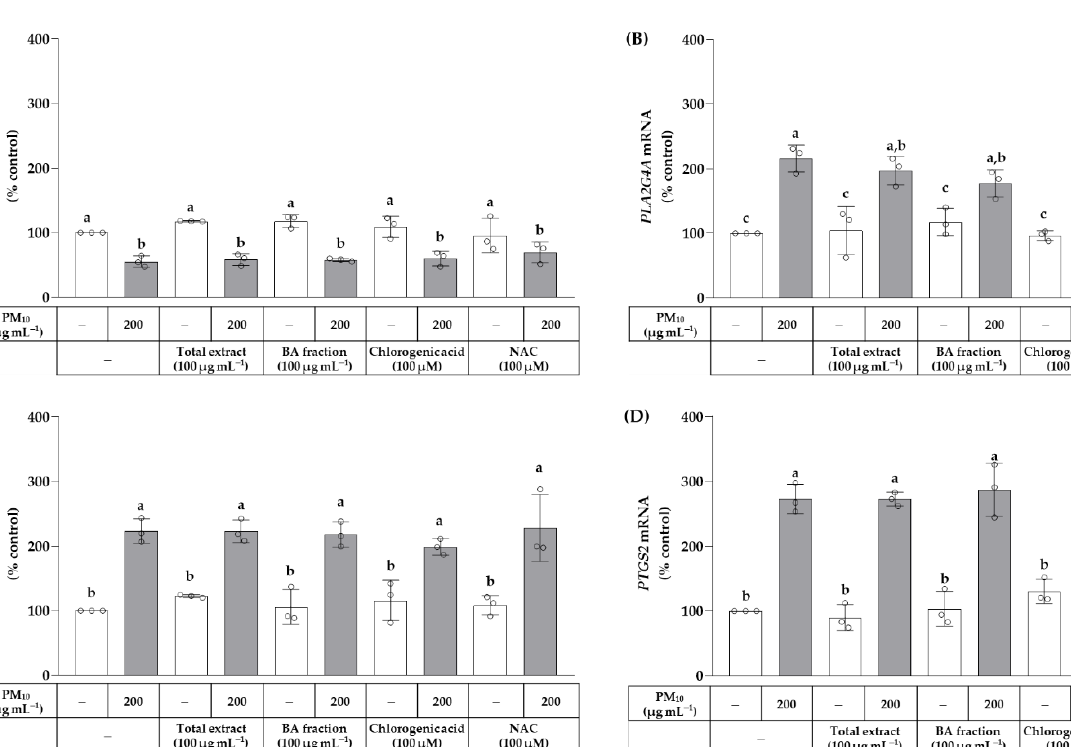
Figure 7. Effects of the total OJ extract, its BA fraction, chlorogenic acid, and NAC on the secreted level of prostaglandin (PG) E 2 in HaCaT keratinocytes exposed to PM 10 . In ( A ), cells were treated with different concentrations of PM 10 . In ( B ), cells were treated with the total OJ extract (100 µ g mL − 1 ), BA fraction (100 µ g mL − 1 ), chlorogenic acid (100 µ M), and NAC (100 µ M), alone or in combination with PM 10 (200 µ g mL − 1 ), for 48 h. The secreted level of PG E 2 was determined using a PG E 2 enzyme-linked immunosorbent assay (ELISA). Data are presented as mean ± SD ( n = 3). Groups that do not share the same lowercase alphabet letters (a–d) are considered to have significantly different means at the p < 0.05 level.